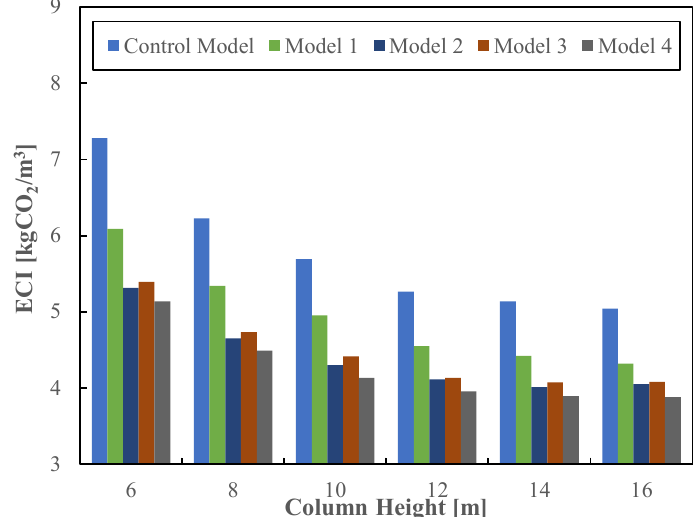
Figure 4. Average ECI variation with column height for different models.